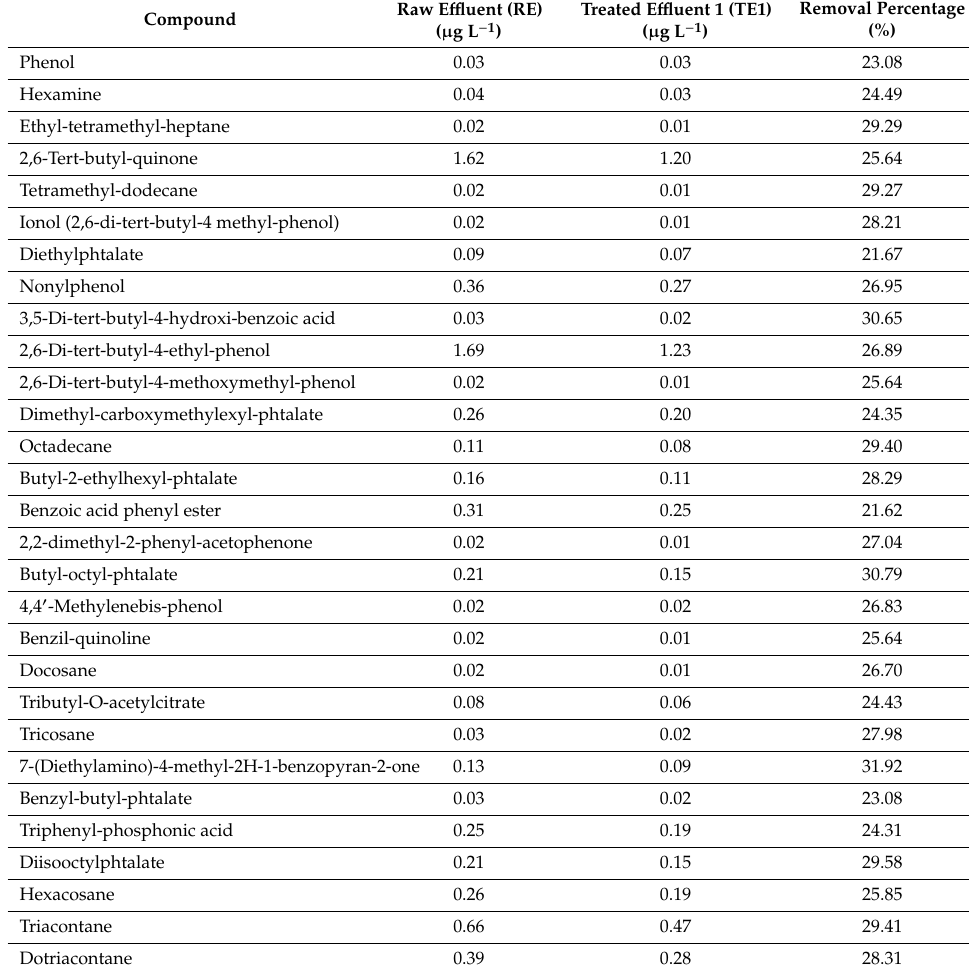
Table 2. Chemical composition found using GC-MS in the textile e ffl uent RE and TE1 samples.